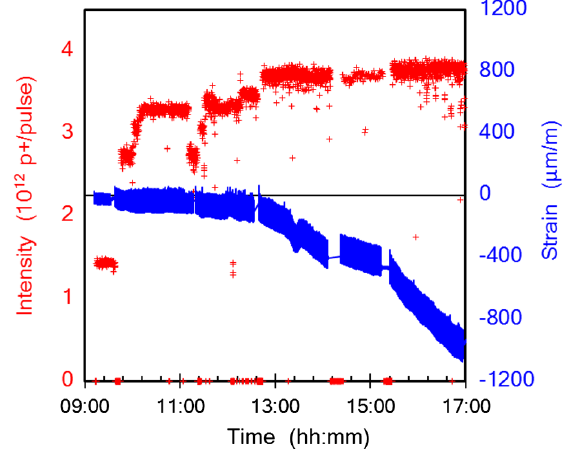
FIG. 17. Transversal strain measured by one of the strain gauges placed in block 9 (T_01) throughout the execution of the tests, and beam intensity on target during the same period of time. A drift in the strain values measured can be clearly noticed, with a higher impact during high intensity beam